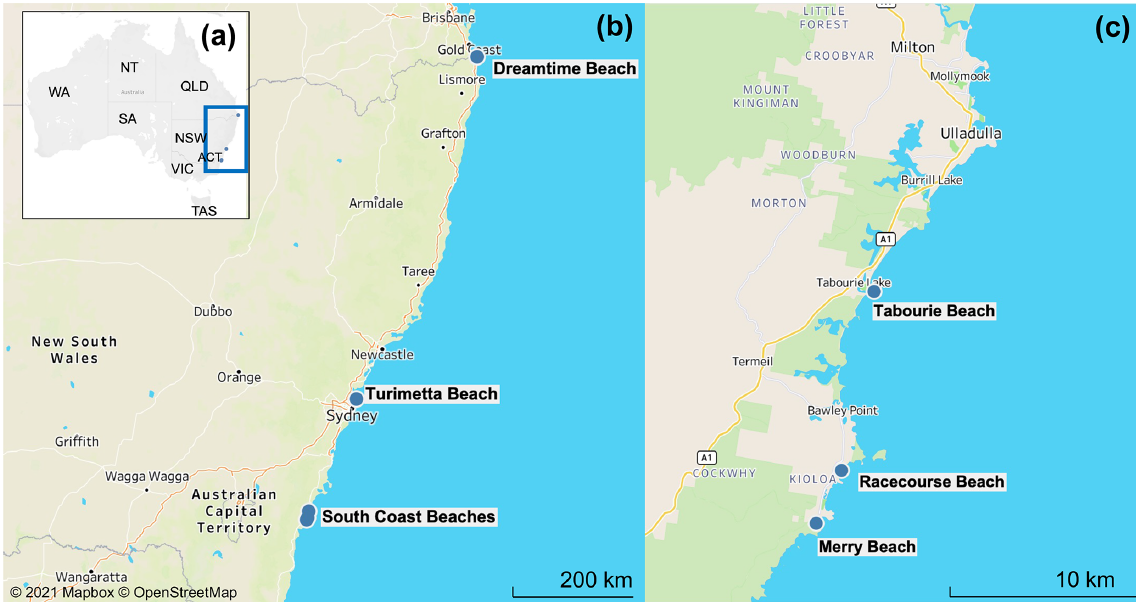
Figure 1. Study sites along the New South Wales Coast, Australia (a, b) . The three nearby South Coast NSW beach (Tabourie Beach, Merry Beach and Racecourse Beach) locations are indicated in (c)